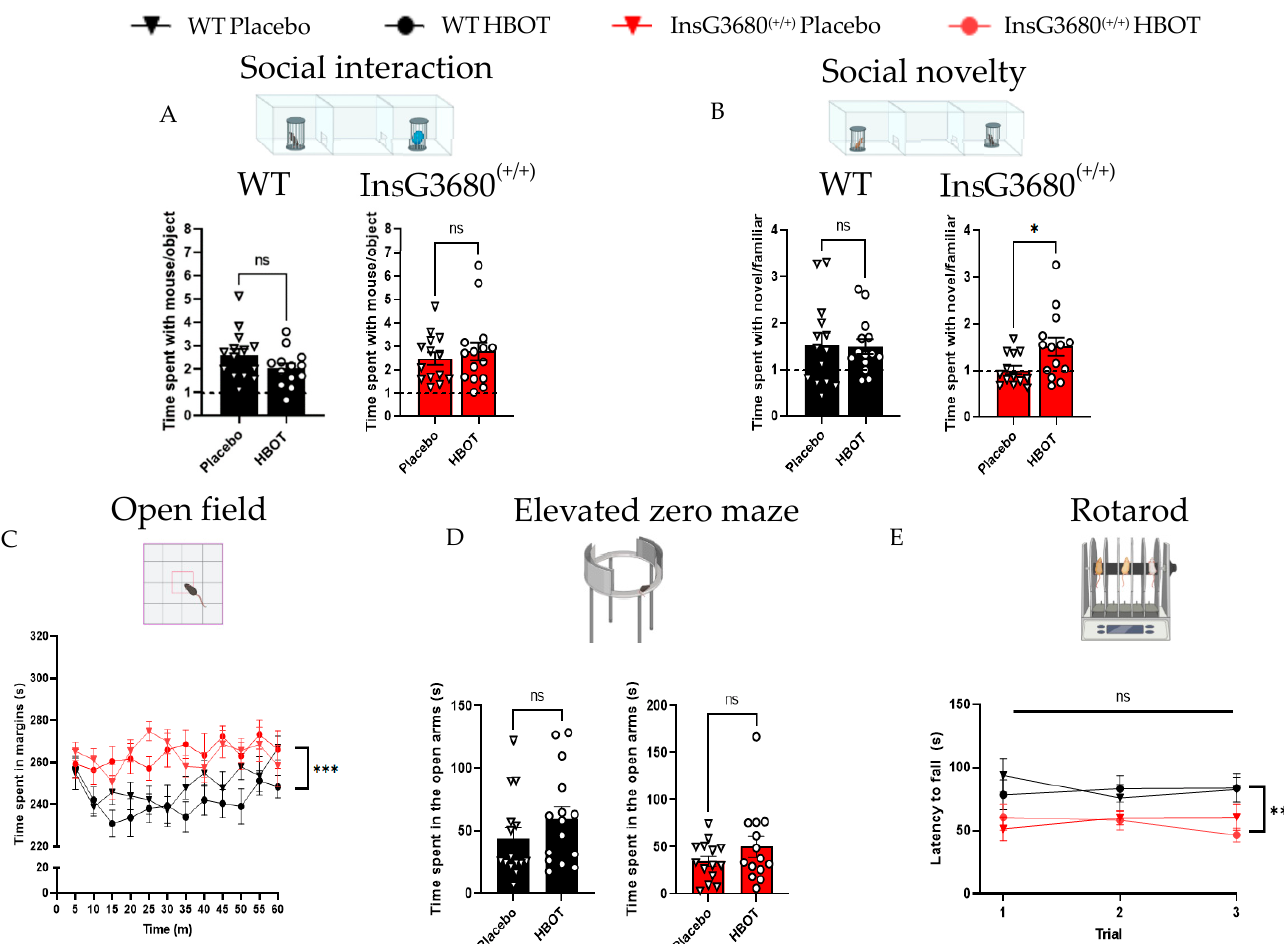
Figure 2. HBOT improves social novelty preference but not anxiety-like behavior or motor coordi- nation in P90 InsG3680 (+/+) mice compared to placebo control mice. ( A ) No significant behavioral differences in the three-chambers social interaction test, as measured by a similar ratio between time spent in close interaction with a stranger mouse and an object in all experimental groups. ( B ) In the three-chambers social novelty test, mice from the InsG3680 (+/+) HBOT group showed a significantly higher preference for interacting with the novel mouse compared to the familiar mouse compared to mice from the InsG3680 (+/+) placebo group. No significant difference in the social novelty index was found between the WT HBOT group and the WT placebo group. ( C ) Time spent in the margins in the open field test, presented in time bins of 5 min. A significant main effect was found between the InsG3680 (+/+) and WT groups. Moreover, in the third time bin, the InsG3680 (+/+) HBOT group spent significantly less time in the margins than the InsG3680 (+/+) placebo group. A similar effect was found in the last time bin between the WT HBOT group and the WT placebo group. ( D ) Time spent in the open arms of the elevated zero maze test. HBOT did not affect the behavior in both genotypes. ( E ) In the rotarod test, no change was found in latency to fall throughout all three trials between HBOT and placebo in both genotypes. However, the WT groups have endured longer on the rotarod compared to InsG3680 (+/+) groups. ns—non significant, * p < 0.05, ** p < 0.01, *** p < 0.0005. Two-tailed t -test ( A , B , D ). 3-way ANOVA with repeated measures ( C , E ). Data are shown as mean ± s.e.m.